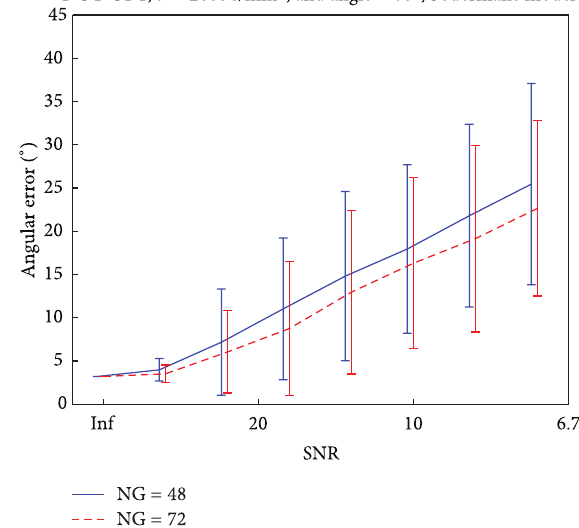
Figure 8: Influence of the gradient sampling schemes on the accuracy of the analytical DOT-ODF imaging for angle of 60 ∘ .